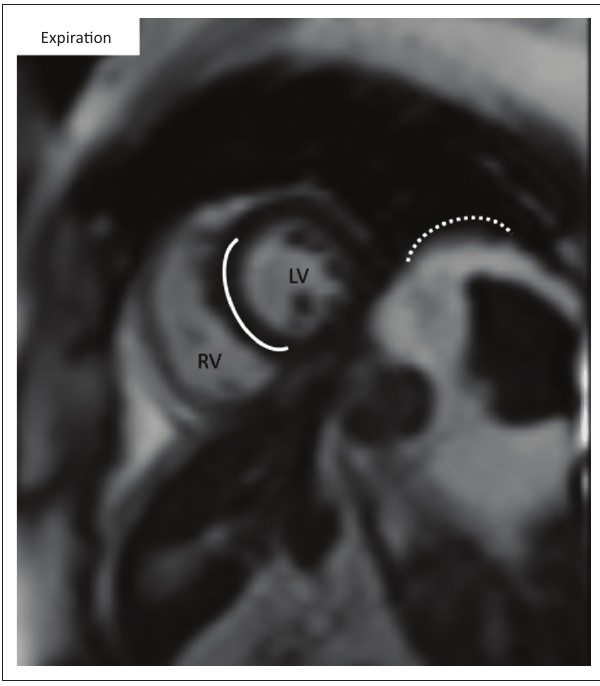
RV, right ventricle; LV, left ventricle. FIGURE 7: A 62-year-old man with constrictive pericarditis. Free-breathing cine SSFP image at the mid-ventricular level on the short-axis view demonstrates bulging (solid line) of the interventricular septum during expiration when the diaphragm is rounded (dotted line).